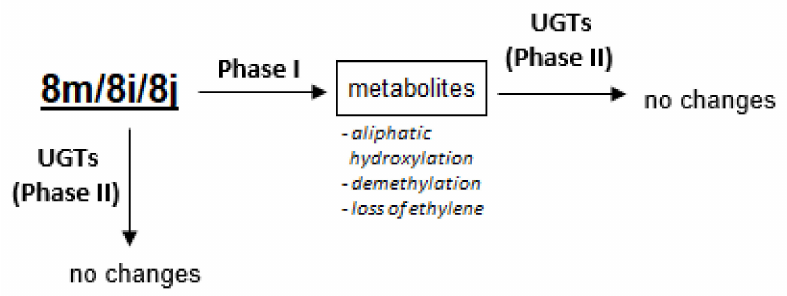
Figure 6. The proposed metabolic pathways of compounds 8m , 8i and 8j